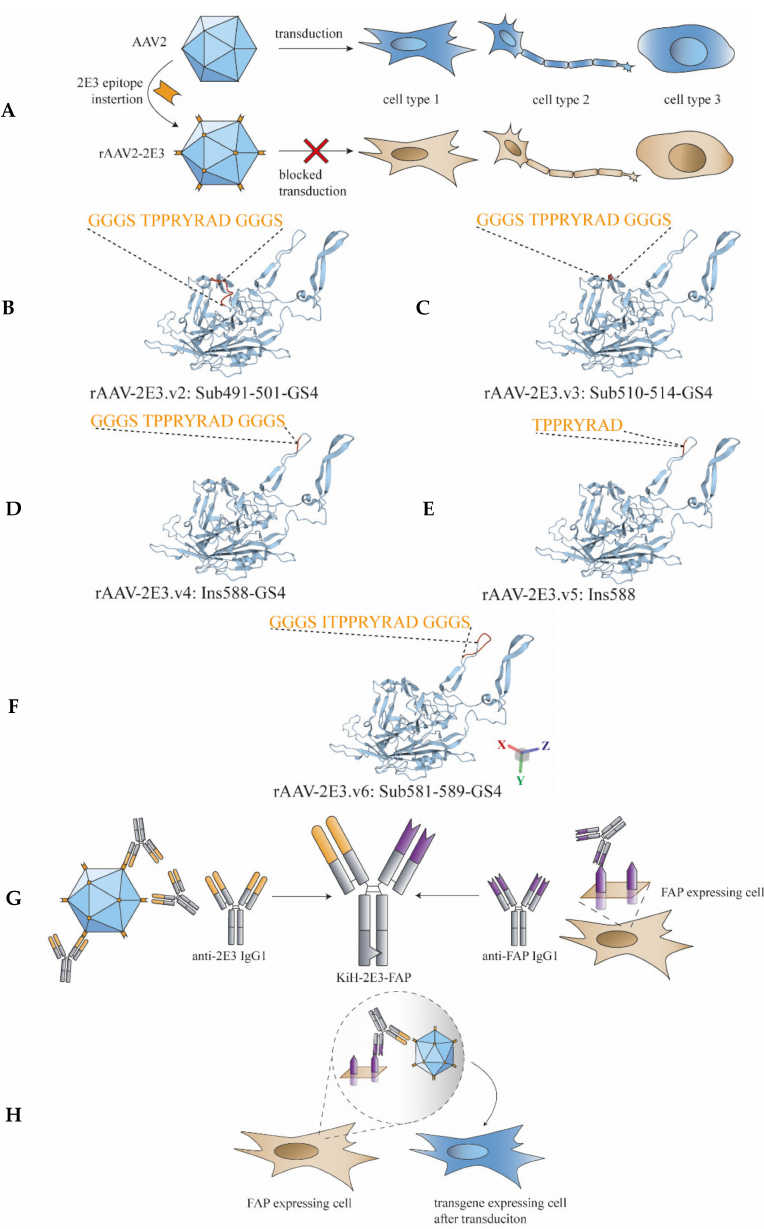
Figure 1. Design of novel AAV capsids and bispecific antibodies to develop a retargeting platform. ( A ) Five versions of linear 2E3 epitopes (orange) were inserted into different areas of the AAV2 capsid, resulting in five novel rAAV-2E3 capsid variants. The inserted peptide aims for the destruction of natural AAV2 tropism and should result in novel rAAV-2E3 variants with reduced transduction properties. Transduced cells are shown in blue, and non-transduced cells are shown in beige. ( B – F ) Ribbon drawing of the VP3 AAV2 subunit. Wild-type structures are shown in blue, and modified regions are indicated in red. Epitope sequences that were inserted and resulted in rAAV-2E3.v1-6 are shown in orange letters. Structures were derived and visualized using the PDB online tool (https://.rcsb.org; Access date: 22.05.2021) based on ID 1LP3. ( G ) Illustration of the design of a knob-into-hole bispecific antibody derived from engineering of monospecific anti-2E3 epitope binding antibody (orange) and a monospecific anti-FAP binding antibody (violet). ( H ) Schematic illustration of the established re-targeting mechanism. A complex of novel rAAV-2E3 variant was formed with bispecific antibody KiH-2E3-FAP. The bispecific antibody served as adaptor between 2E3 epitope and cell surface receptor FAP. Cells expressing FAP were bound, resulting in transduction and gene expression (blue